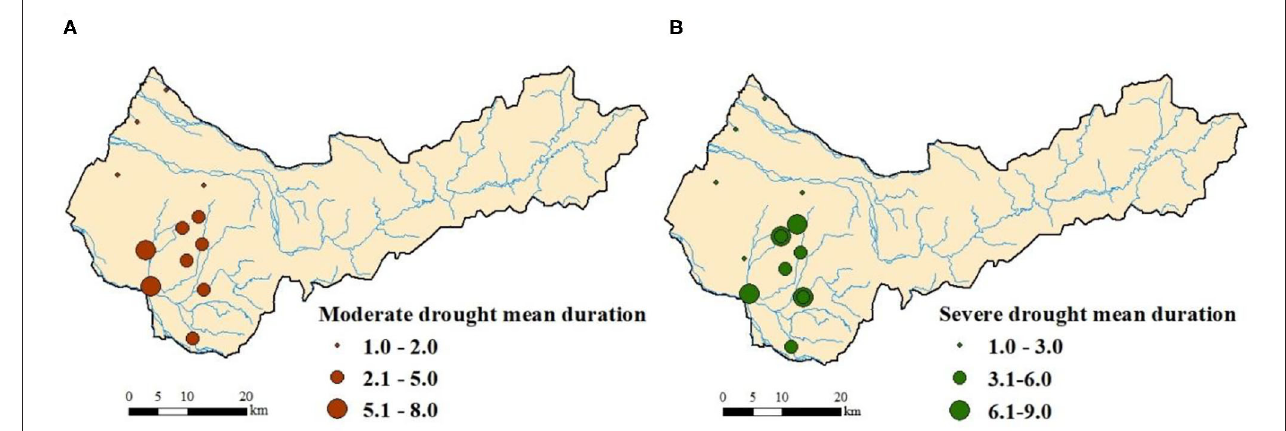
FIGURE 7 | Mean duration of (A) moderate groundwater drought and (B) severe groundwater